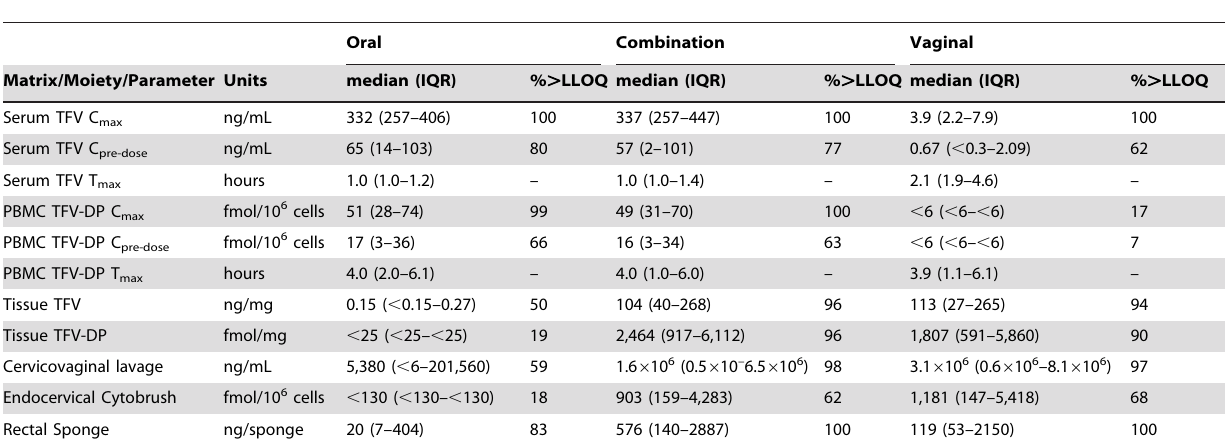
Table 3. Summary of TFV and TFV-DP concentrations at all sampled anatomic sites.